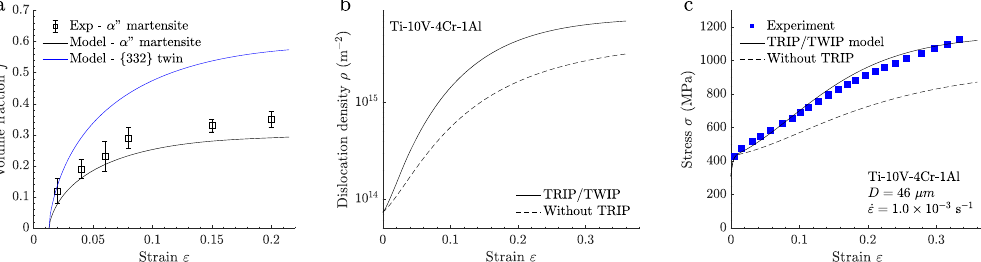
Fig. 3 Microstructural evolution and mechanical response of Ti-10V-4Cr-1Al. a The growth of twin and martensite volume fraction over strain. The error bars on martensite fraction were adopted from the experimental measurement 16 . b The increase of total dislocation density. c The experimental and modelled stress-strain curves, where the dash curve illustrates the fl ow stress subtracting TRIP